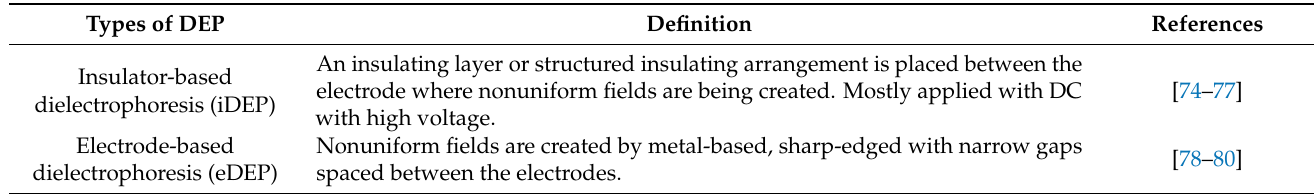
Table 3. Different types of DEP and their